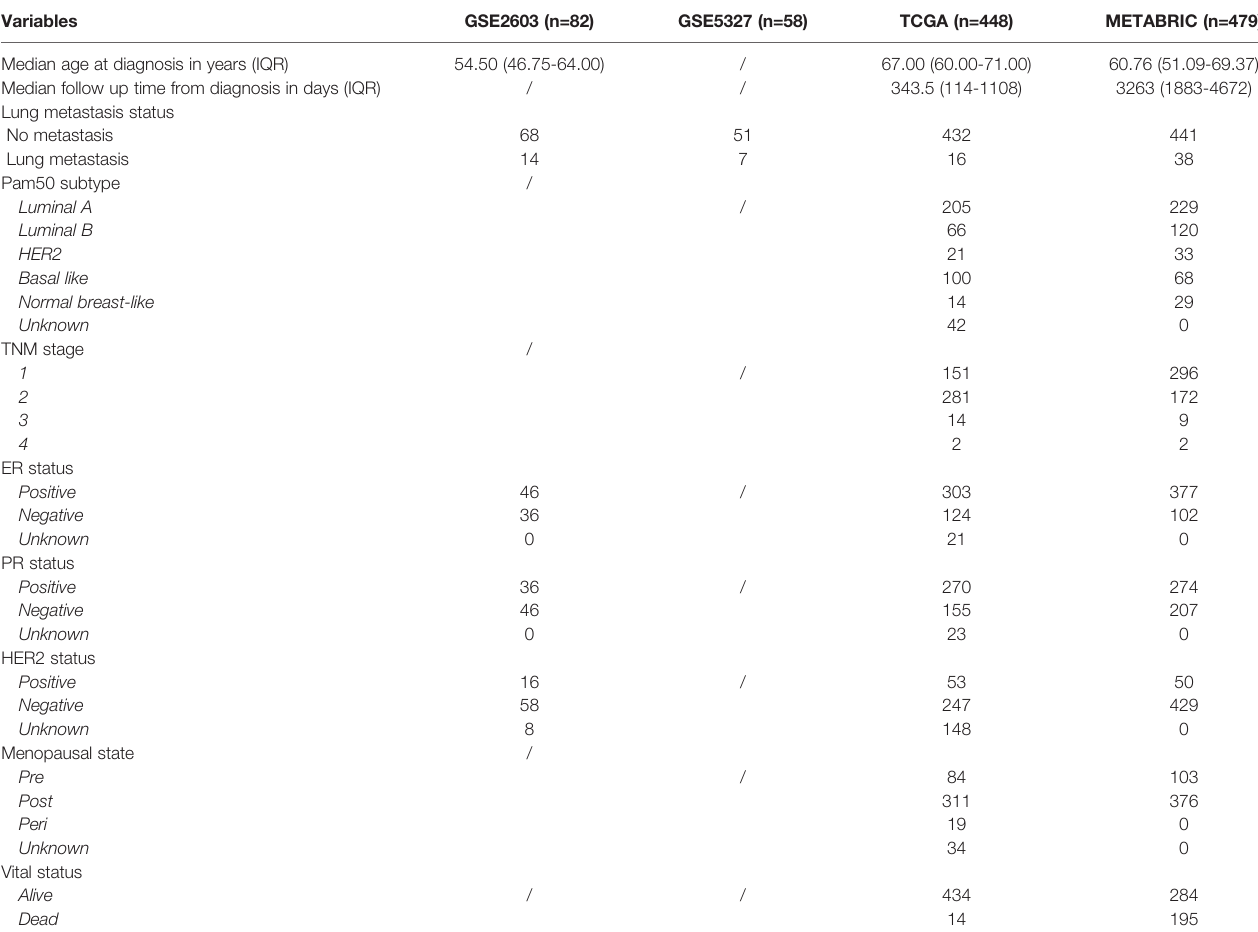
TABLE 1 | Demographics of the patients chosen for the study.